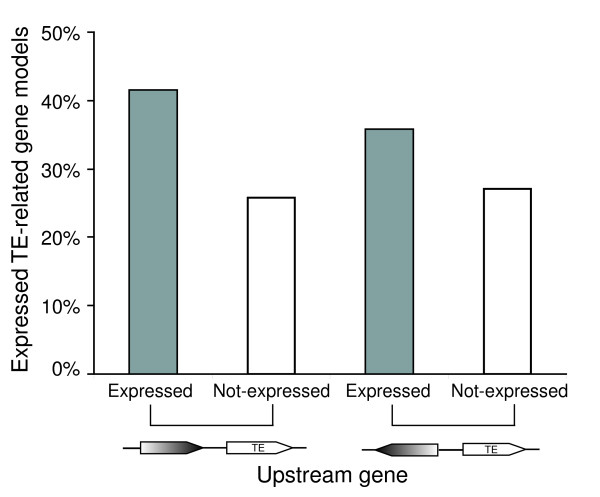
Effects of relative orientation of upstream genes on transcription of downstream TE-related genes. All TE-related genes were divided into two groups according to the relative orientations of themselves and upstream genes. Portions of transcribed TE-related genes were calculated for those with transcribed upstream genes and those with silent upstream genes in both groups. TE, transposable element.